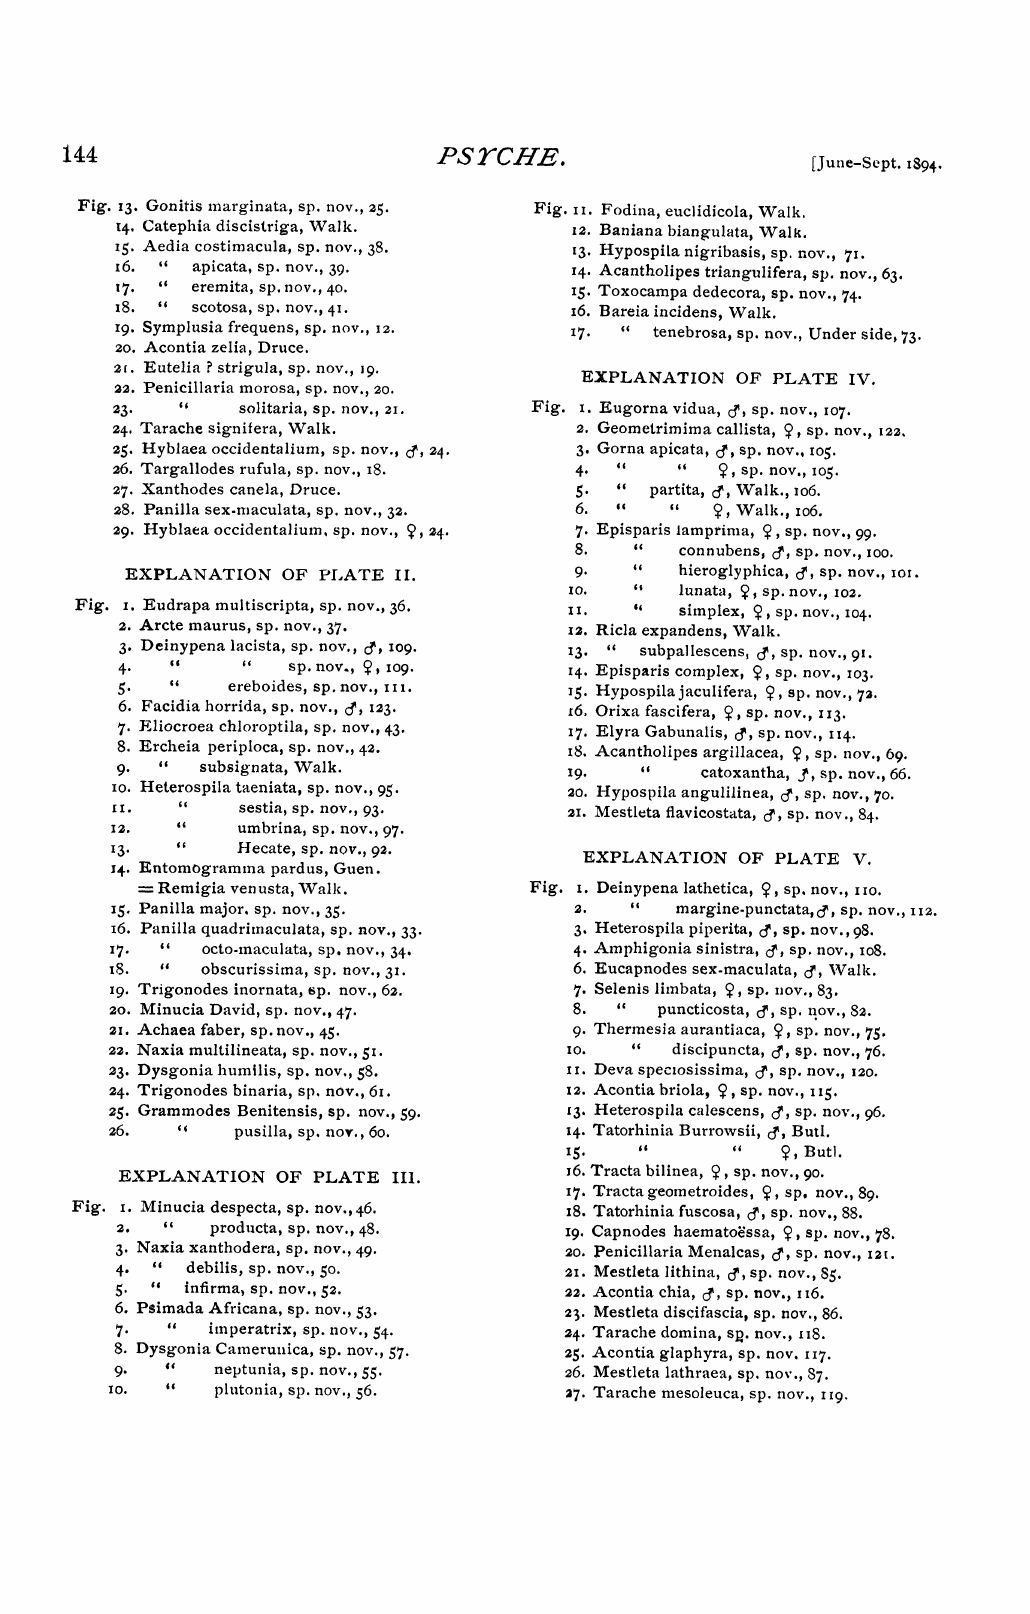
Fig. I3. Oonitis marginata, sp. nov., 25. 4. Catephia discistriga, Walk. 15. Aedia costimacula, sp. nov., 38. t6. apicata, sp. nov., 39. 7, eremita, sp. nov., 4o. 18. scotosa, sp. nov., 19. Symplusia frequens, sp. nov., 2o. Acontia zelia, Druce. 2[. Eutelia strigula, sp. nov., 19. 22. Penicillaria morosa, sp. nov., 2o. 23. 29. Hyblaea occidentalium, sp. nov., EXPLANATION OF PLATE I. Fig. i. Eudrapa multiscripta, sp. nov., 36. 2. Arcte maurus, sp. nov., 37. 3. Deinypena lacista, sp. nov., 0", xo9. 4. sp. nov., 5" 9. 26. pusilla, sp. nov., 60. Fig. Minucia despecta, sp. nov.,46. . 2. 4. debilis, sp. nov., 5o.